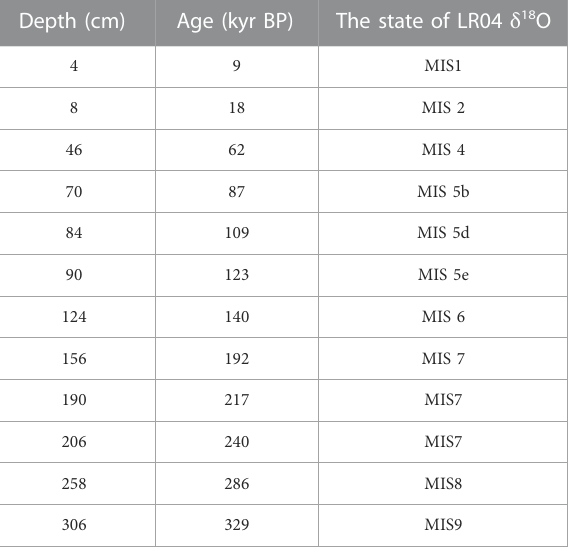
TABLE 1 Age control points at different depths of the H10